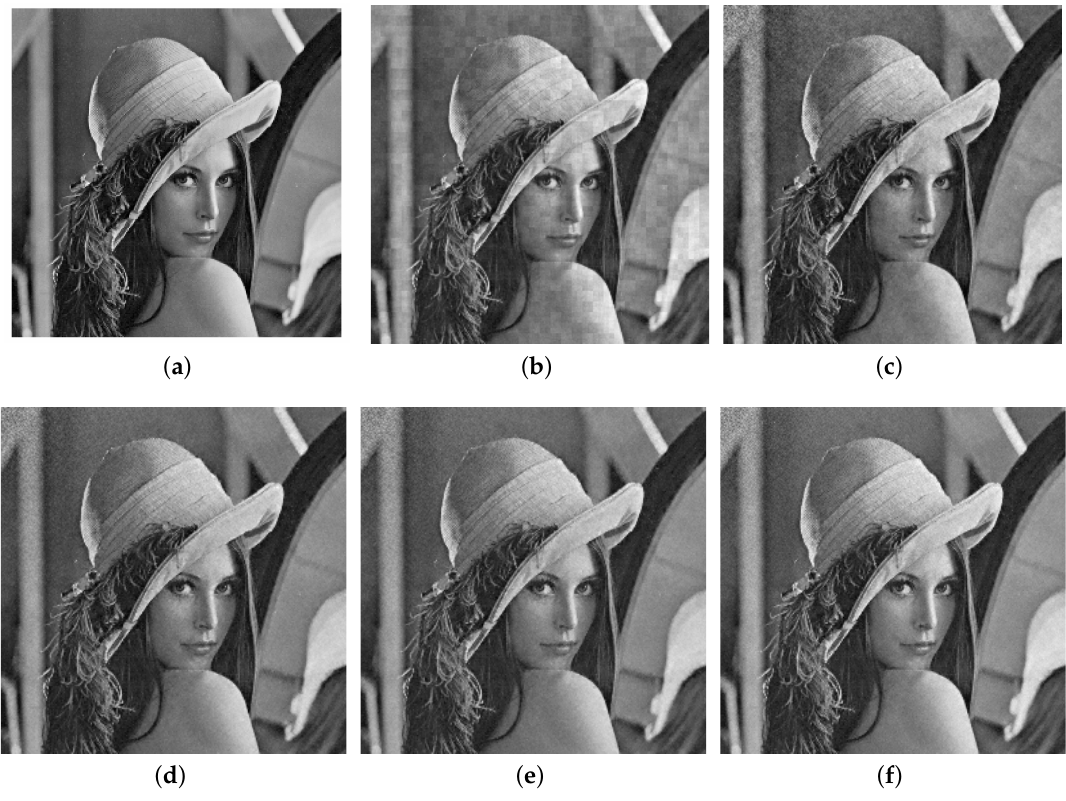
Figure 4. The VSI score of the four images is 0.95 ± 0.01. From left to right: ( a ) the original image; ( b ) the image produced by the saliency modulated Liu JND model; ( c ) the image produced by the saliency modulated K JND model; ( d ) the image produced by the saliency modulated Cui JND model; ( e ) the image produced by the saliency modulated Zebbiche JND model; ( f ) the image produced by the proposed saliency modulated method. The PSNR values of the last five pictures are 30.8715, 30.6411, 30.3502, 30.1301 and